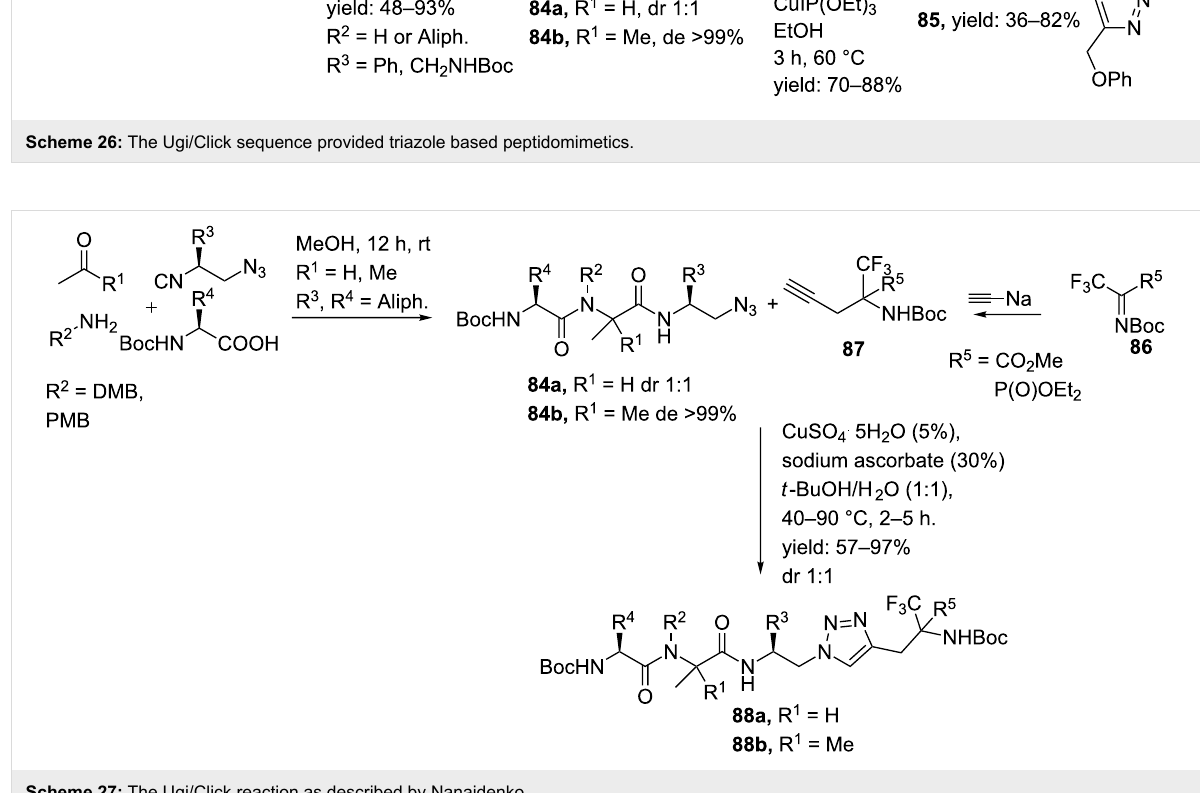
provided the azide moieties 84a or 84b , whereas a reaction between sodium acetylide and imines of general structure